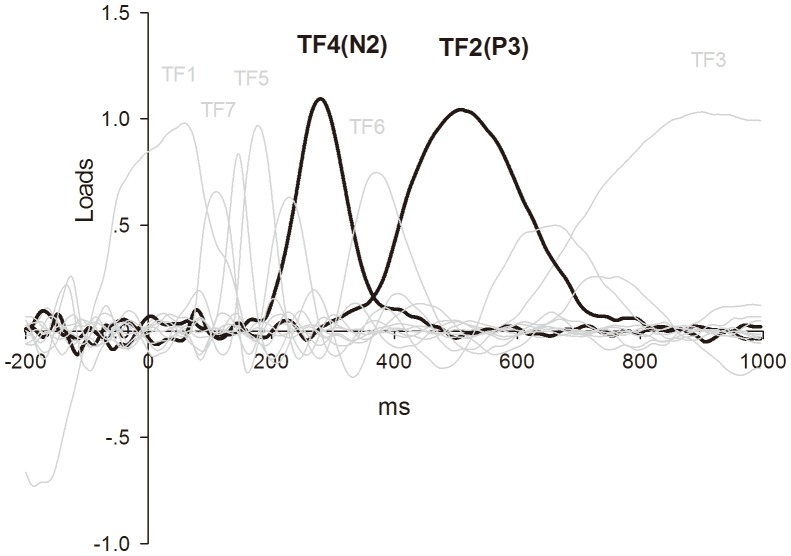
tPCA: factor loadings after promax rotation.TF4 (N2) and TF2 (P3) are drawn in black.